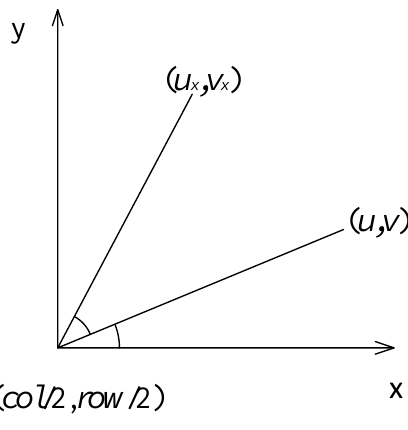
Figure 5. Polar coordinate system. The rotation matrix can be used to calculate the coordinates of the upper left vertex ( u ) and the lower right vertex ( u ) of the circumscribed rectangle of the sugarcane 0 , v 0 1 , v 1 contour after rotation. The circumscribed rectangle of the sugarcane contour was redrawn through these two points and the circumscribed rectangle was used to obtain an image of